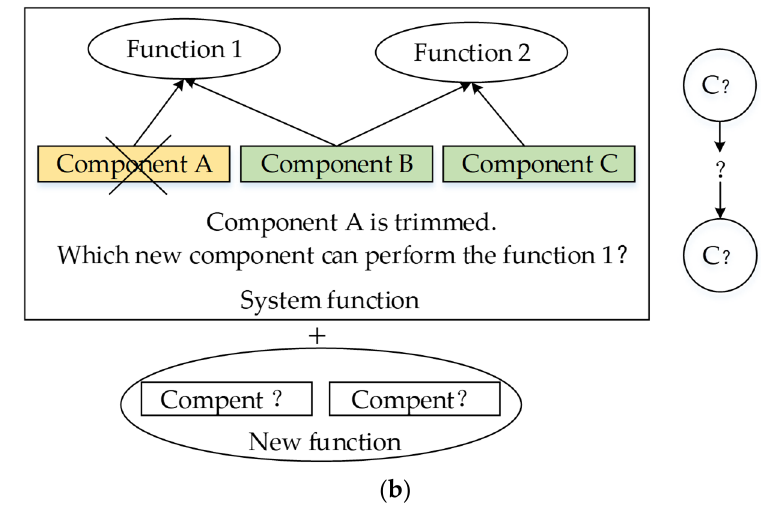
Figure 3. ( a ) The cause-effect relationship of the complicated problem; ( b ) The conflict relationship of the complicated problem.